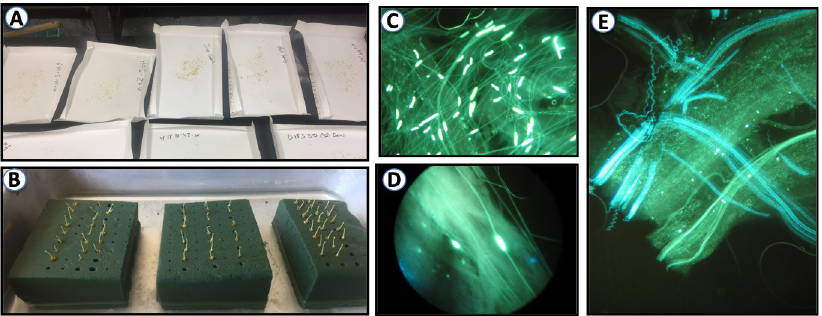
Fig 1. Pollen tube growth in prune flowers. Preparation of pollen grains and drying anthers before being used to hand-pollinate the pistils (A), emasculated flowers on wet florist foam (B), pollen grains in self-pollinated flowers of prune germinating at the stigma (C), pollen tubes growing along the style (D), pollen tubes reaching the base of the style (E).